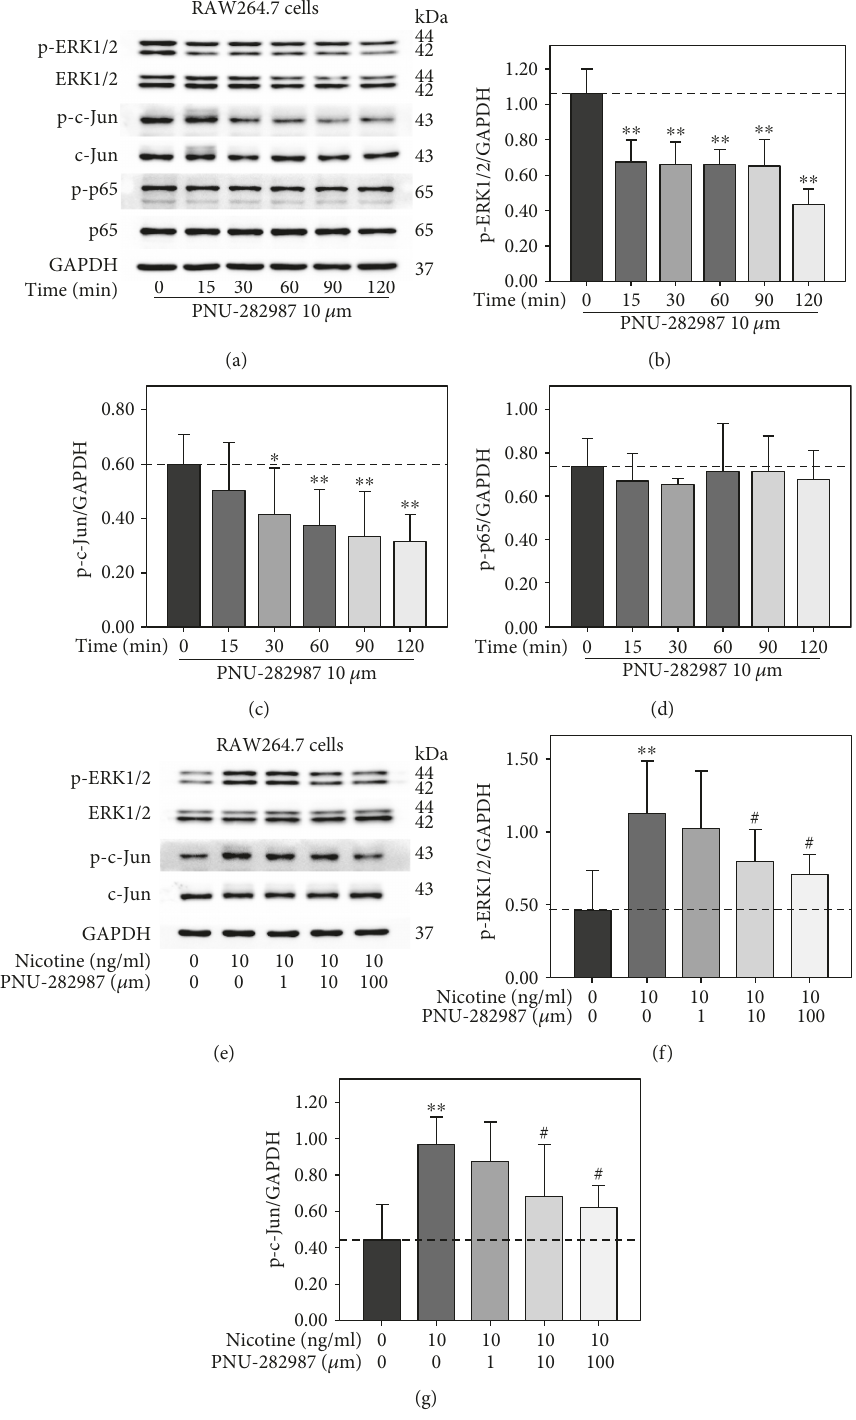
Figure 4: PNU-282987 suppressed nicotine-stimulated activation of extracellular signal-regulated kinase1/2 (ERK1/2) and c-Jun in RAW264.7 cells. (a) RAW264.7 cells were treated with 10 μ m PNU-282987 for 0, 15, 30, 60, 90, and 120min. (e) RAW264.7 cells were pretreated with 10 μ m PNU-282987 for 60min prior to 10ng/ml nicotine exposure for 30min. Protein levels of p-ERK1/2, ERK1/2, p-c- Jun, c-Jun, p-p65, and p65 were measured by Western blot, and the intensity of protein bands (means ± SD) (b – d, f, g) were assessed using ImageJ software, with all experiments being analyzed as three di ff erent independent experiments and GAPDH used as an internal control. ∗ p < 0 05 and ∗∗ p < 0 01 versus controls; # p < 0 05 and ## p < 0 01 versus the group treated with